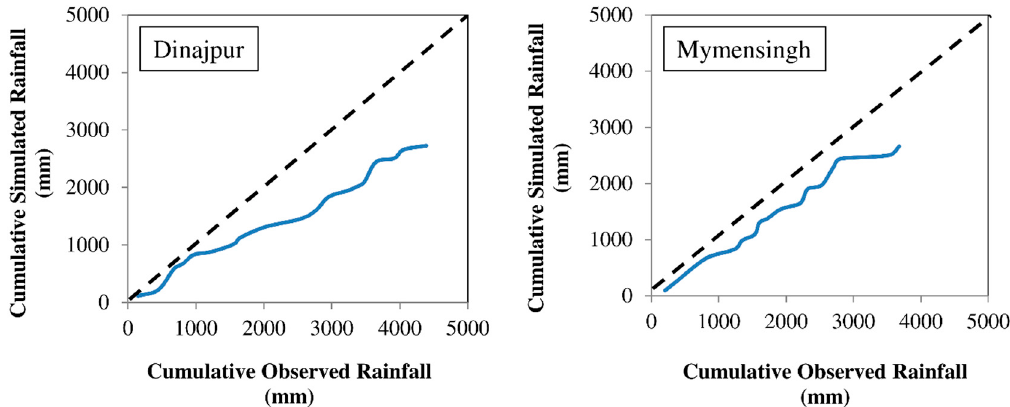
Figure 6. Double mass curve of annual maximum rainfalls at Dinajpur ( left ) and Mymensingh ( right ) of the base period (1986–2005).